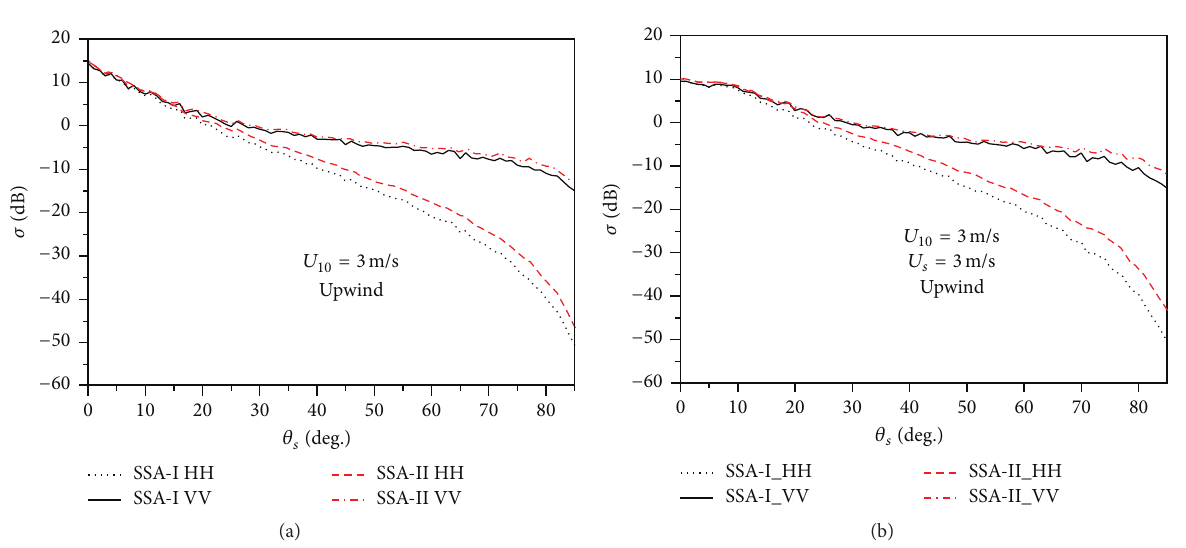
Figure 4: Comparison between SSA-I and SSA-II for copolarized backscattering coefficient with different wind speed 𝑈 10 = 3 m/s. (a) Sea surface alone and (b) sea surface with